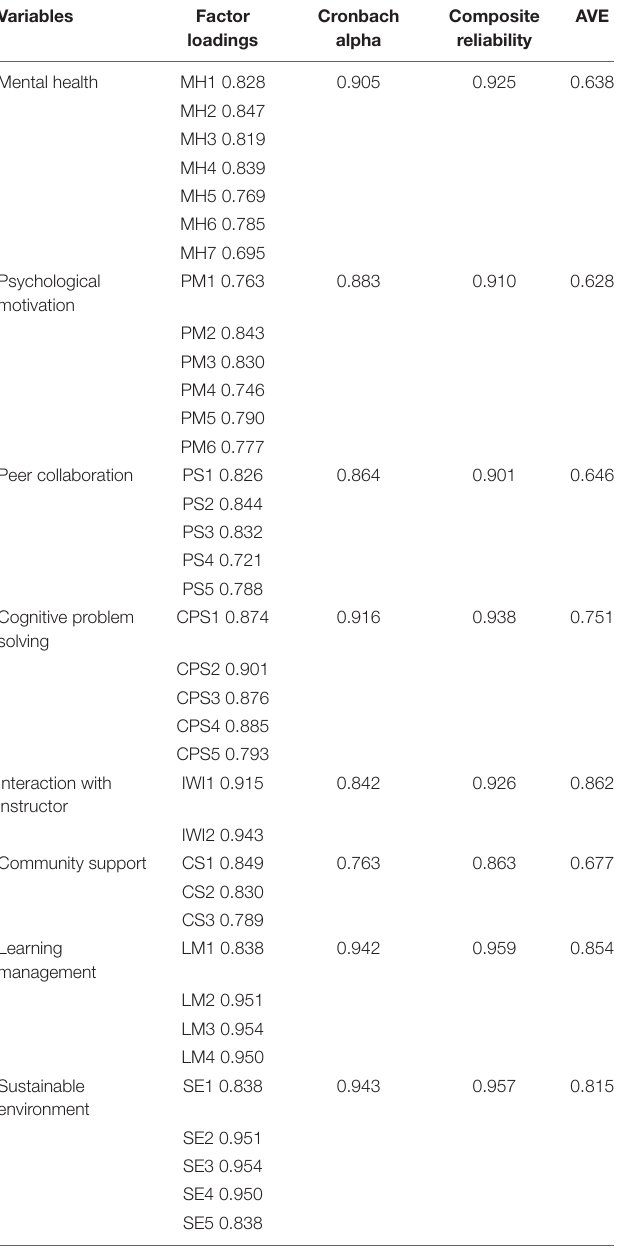
TABLE 2 | Factor loadings and average variance extracted. Variables Factor loadings